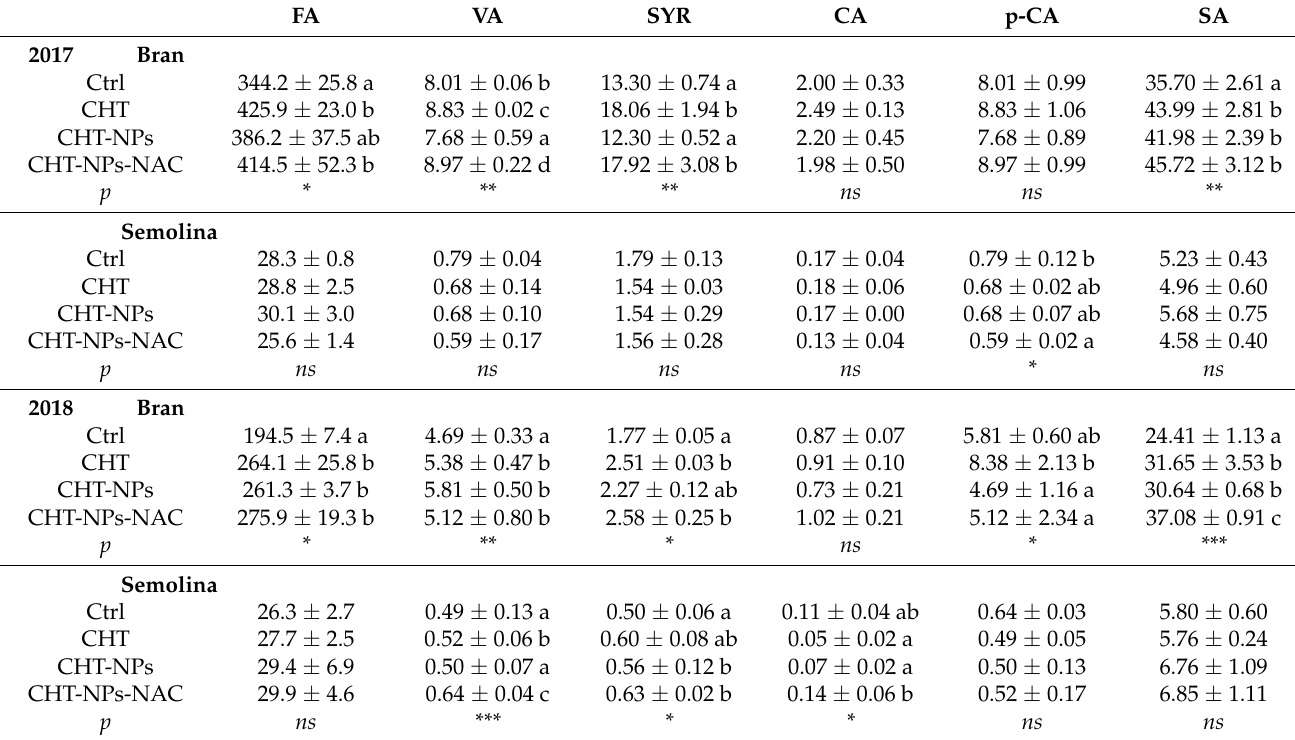
Table 1. Phenolic acid content (mg/100 g) in bran and semolina obtained from Triticum durum (cv. Fabulis) in 2017 and 2018, untreated (Ctrl) or treated with CHT, CHT-NPs, or CHT-NPs-NAC. All data are reported as mean ± standard deviation ( n = 3) a